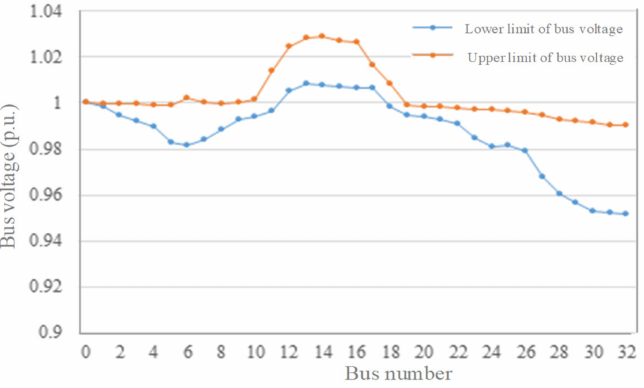
Figure 3. Bus voltage in power system with uncertainty considered under low